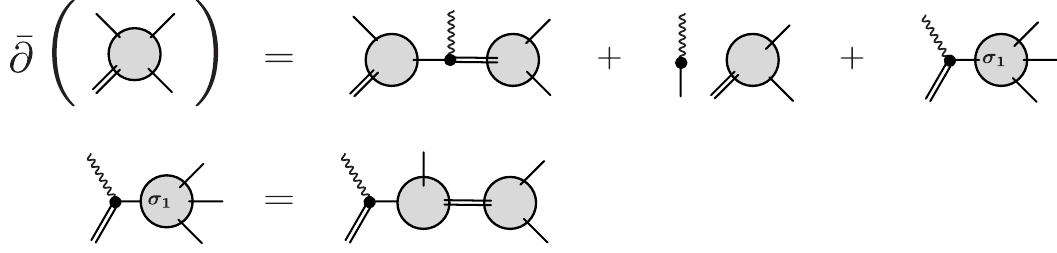
Figure 1 . Graphical representation of the holomorphic anomaly equation (1.23) for correlation functions on fourfolds with flux background. Single lines denote (1 , 1) -form fields, double lines (2 , 2) -form fields, wavy lines the antichiral ( − 1 , − 1) -charged field, and solid bullets correspond to classical couplings (in the limit (2.56) we are considering). The second line shows the factorization of the gravitational descendant term in terms of stable